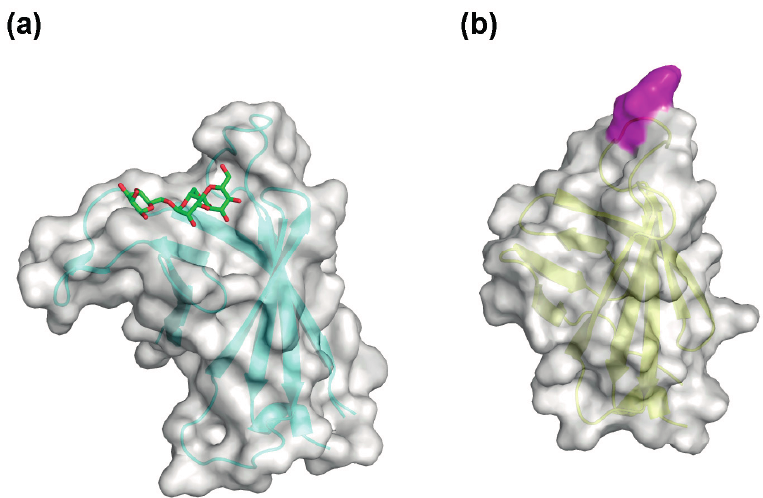
Figure 2. Transparent surface models of the MRH domains of OS-9 (PDB code: 3AIH) [18] and glucosidase II β subunit (PDB code: 2LVX) [17] are shown in ( a , b ), respectively. Bound α 1,6-linked mannotriose in the crystal structure of the MRH domain of OS-9 is shown as stick models. Residues interacting with the M9 oligosaccharide evaluated using NMR data of the MRH domain of the glucosidase II β subunit are colored in magenta. Trp409 is colored in